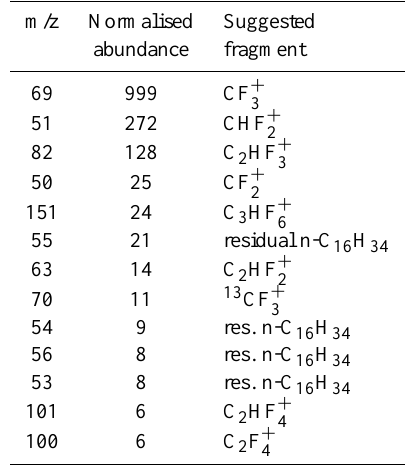
Table 1. Mass spectral data for HFC-227ea obtained from a 143ppt dilution in nitrogen as measured on a GC-MS system in scan mode which gives only low mass resolution (see text for details). The spectrum was background-corrected, but some minor residual peaks resulting from the internal mass axis calibration gas (i.e. n- hexadecane) remain. The major peaks are the same as in the mass spectrum reported by Reizian-Fouley et al. (1997) except for an ad- ditional peak reported at m/z 117 which is a very untypical mass fragment for HFC-227ea and was not observed in this study.